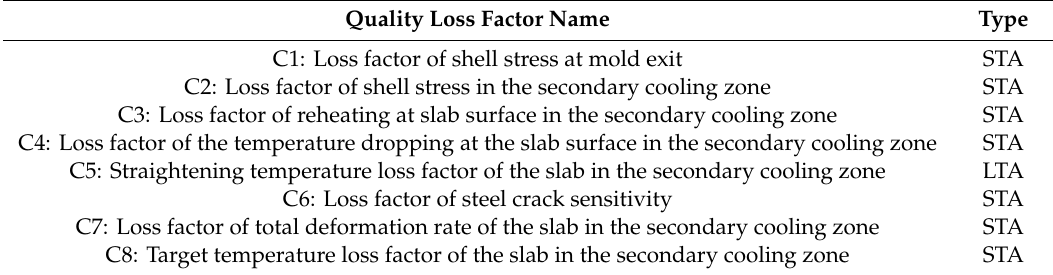
Table 2. Quality loss factor of internal